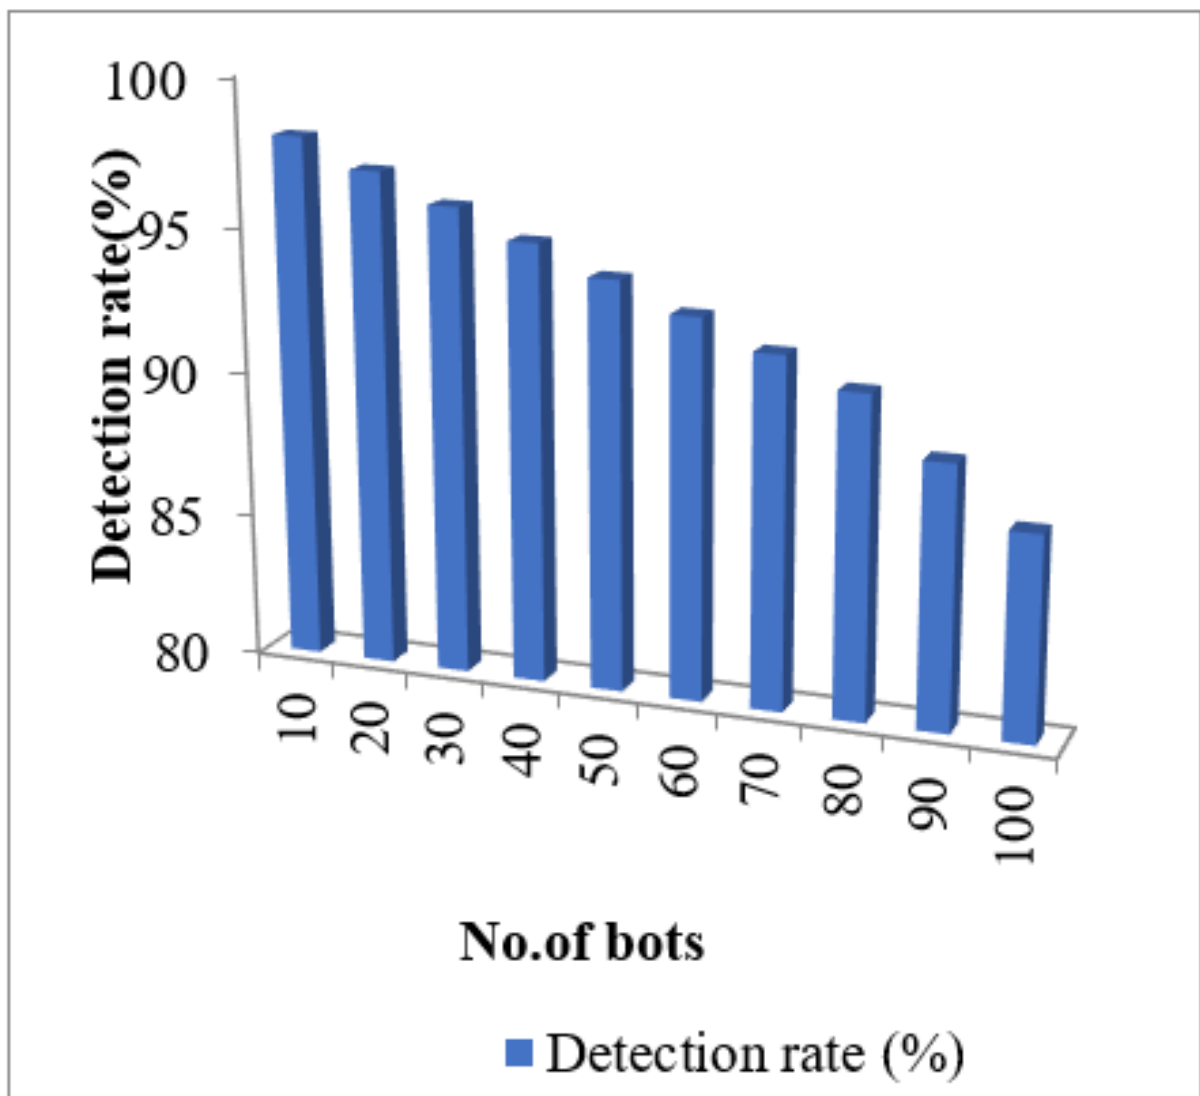
Figure 6. Graphical illustration of malicious packets detection rate analysis.